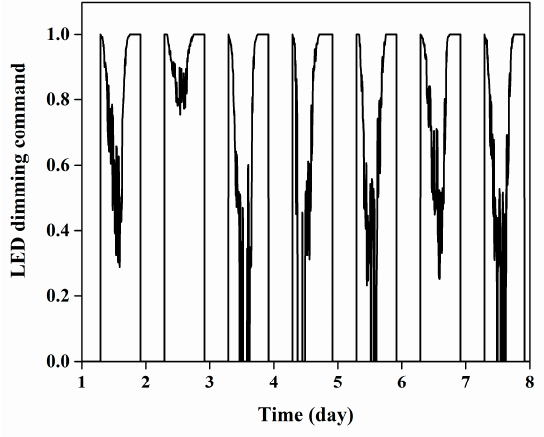
Figure 11. Illuminance (—: natural illuminance and - -: indoor illuminance).